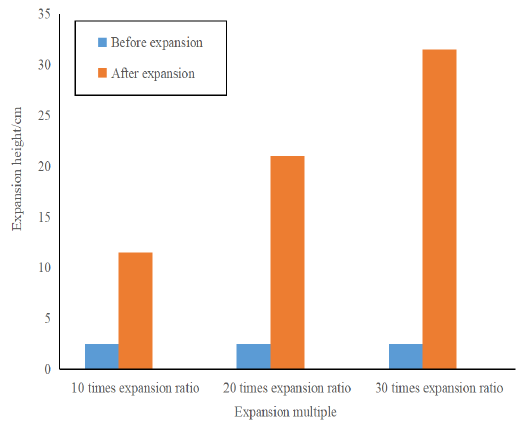
Figure 2. Comparison of slurry height before and after reaction.